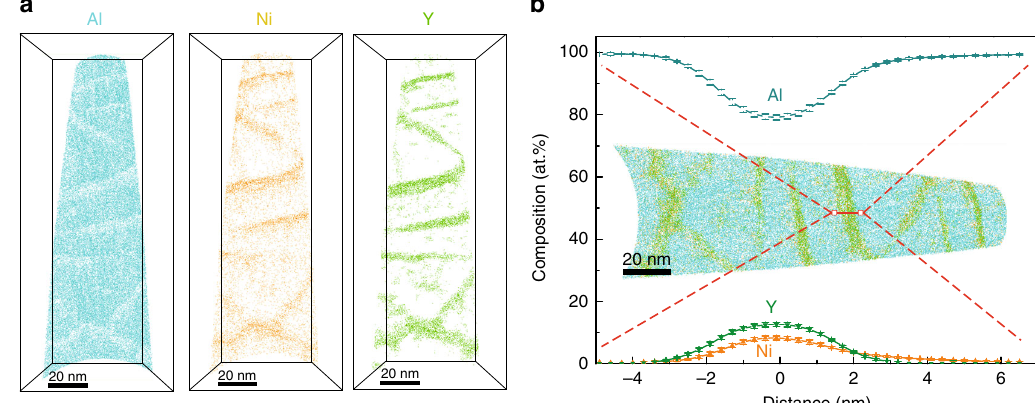
Fig. 2 3D heterogeneity of the hierarchical nanostructured Al alloy. a Thin slice from three-dimensional reconstruction of an APT dataset, showing Ni and Y elements enrichment in the interface between pure Al nanograins. b Atom distribution showing the composition change across the selected interface. The error bars are standard